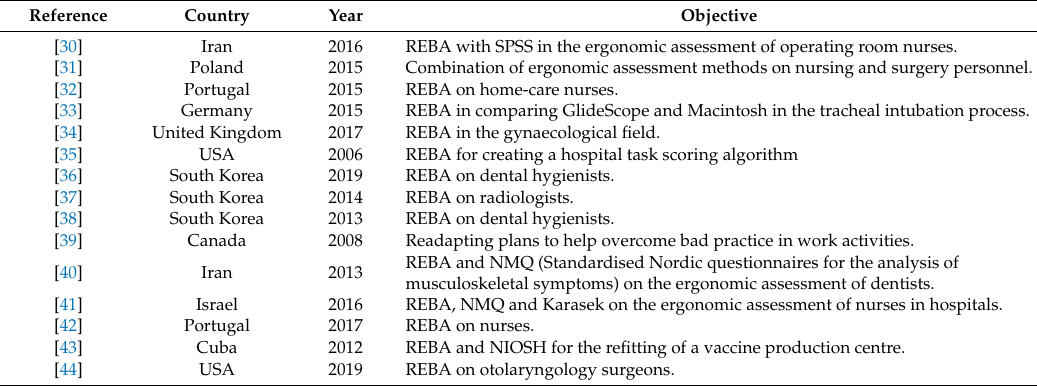
Table 3. Human health and social work